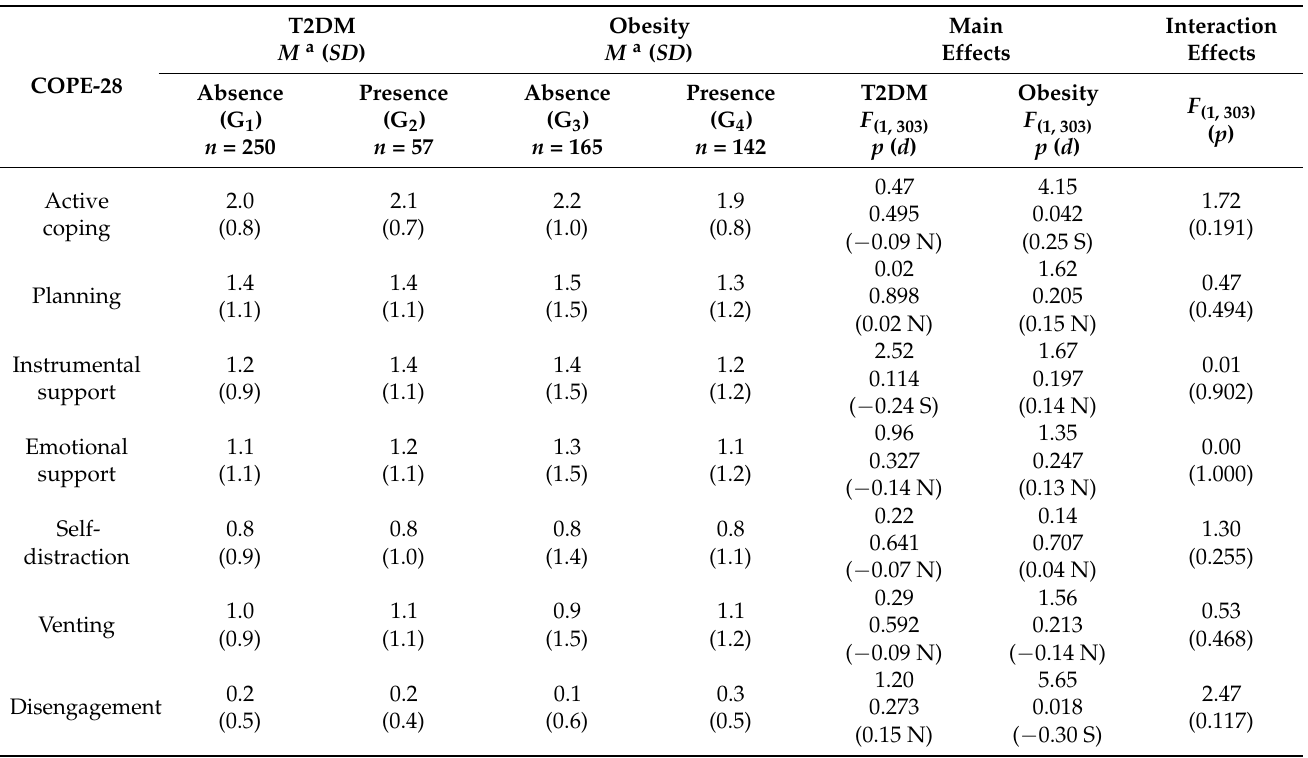
Table 5. Coping Strategies (COPE-28) of Patients with NAFLD by T2DM (Absence and Presence) and Obesity (Absence and Presence) Variables.